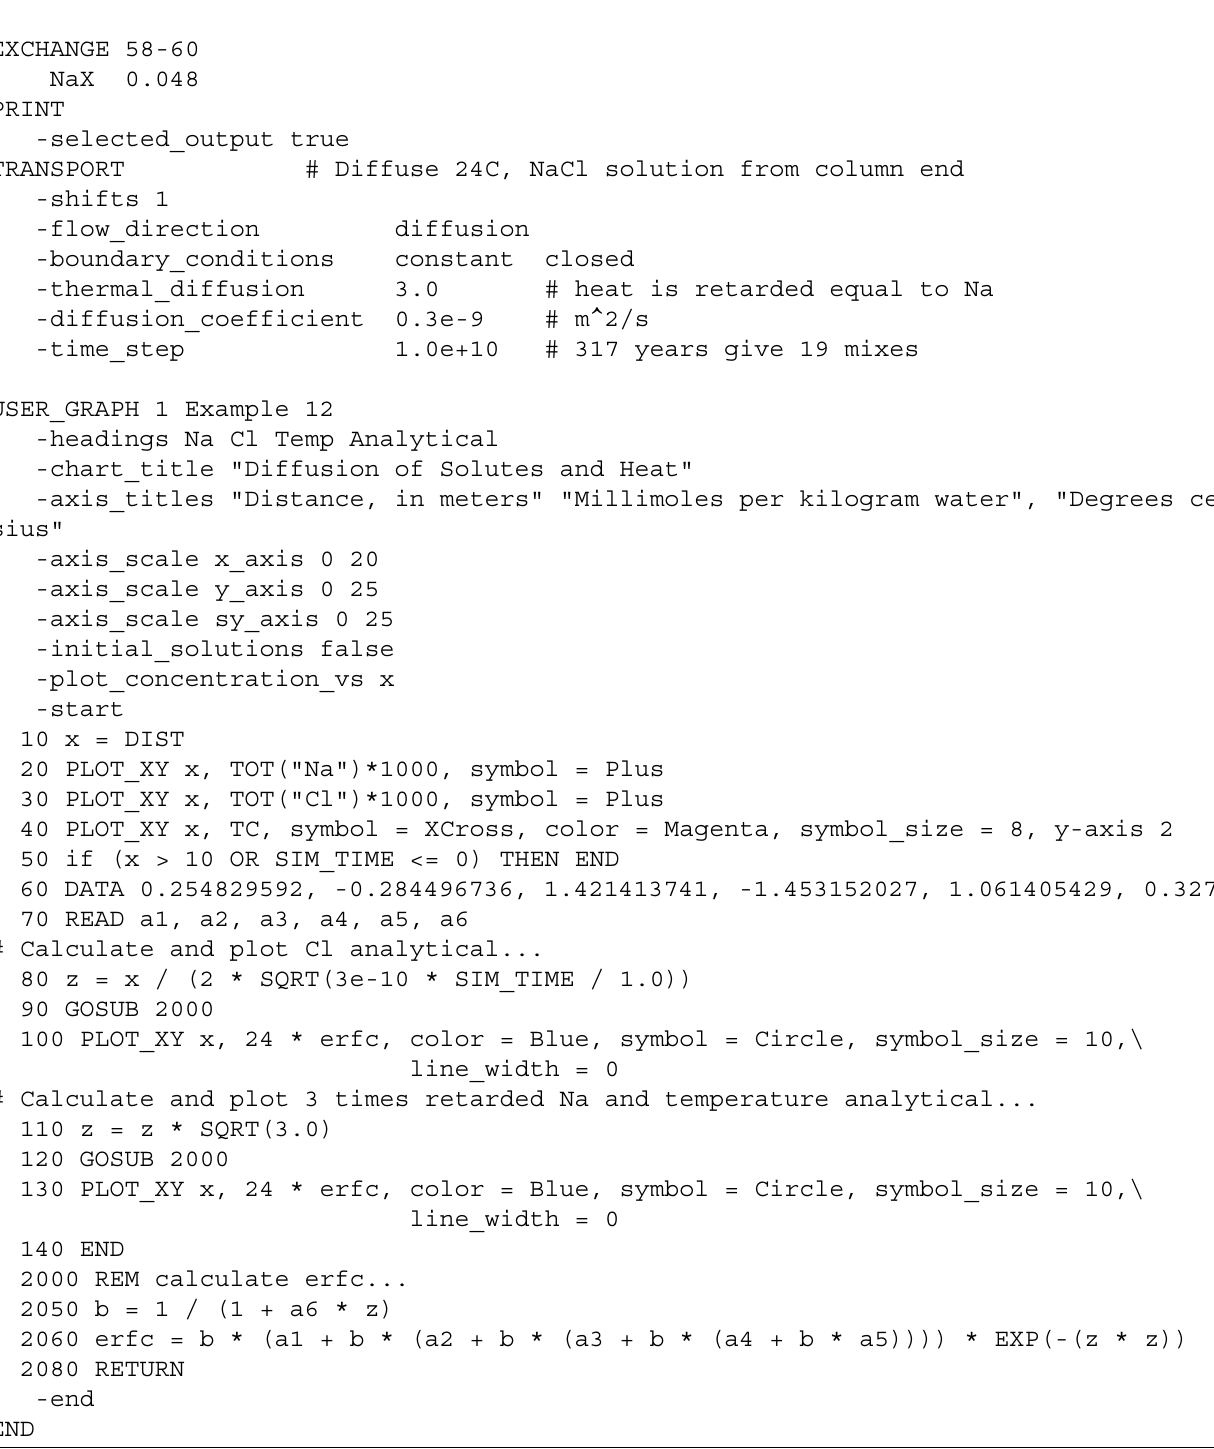
Table 31. Input file for example